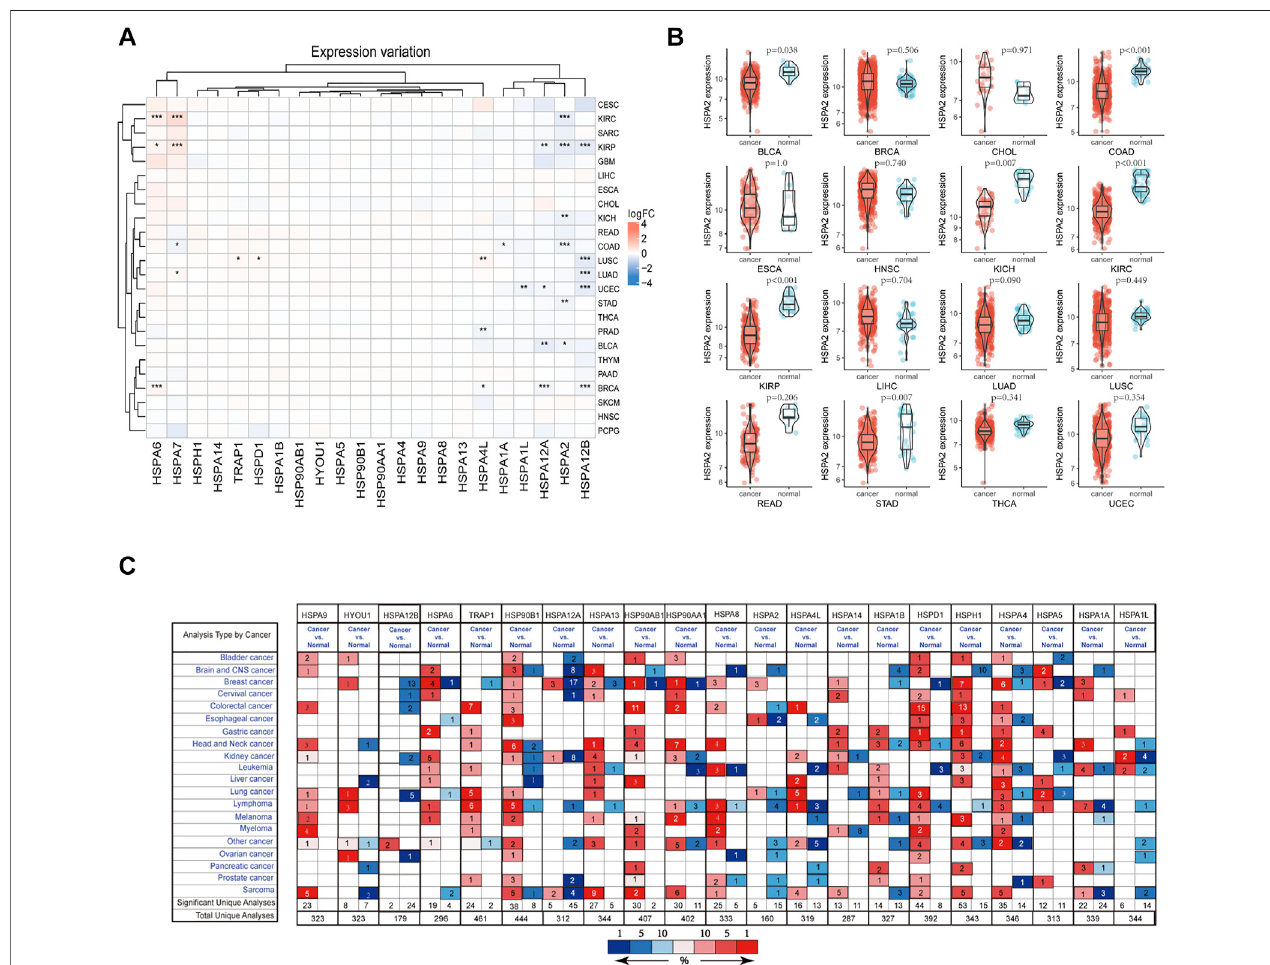
FIGURE 1 | HSP expressions at mRNA level. (A) The differentially expressed of heat shock proteins in pan-cancer. The color in heat map represents the log2 fold changevaluebetweencancerandnormal. Redcolorrepresentsup-regulatedandbluecolorrepresentsdown-regulated.* p < 0.05,** p < 0.01,*** p < 0.001. (B) HSPA2 expression in 16 types of cancers between cancer and normal tissues. (C) Expression pro fi le of HSPs in different human cancer from Oncomine database. Red color represents up-regulated and blue color represents down-regulated. Cell color is determined by the best gene rank percentile for the analyses within the cell. HSP, heat shock